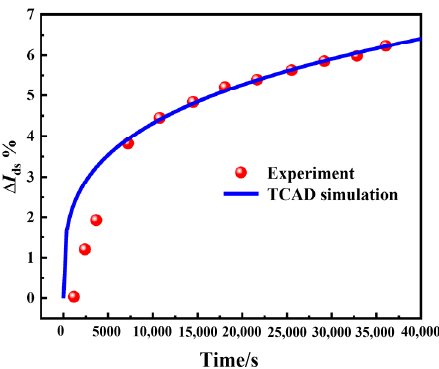
Figure 6. ( a ) I ‐ V curve degradation of GaN HEMTs with time at hot ‐ electron stress V ds = 30 V, V gs = − 1 V and ( b ) transfer and transconductance characteristic degradation of GaN HEMTs.